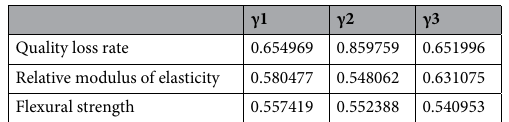
Table 9. Numerical results of correlation